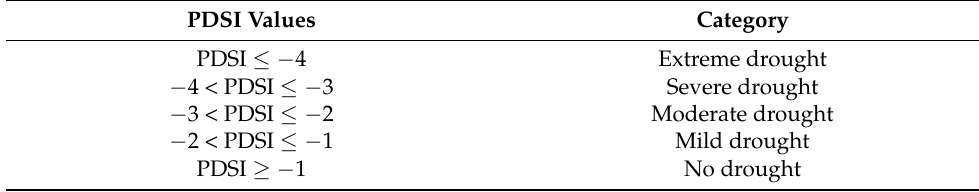
Table 4. Classification of drought based on PDSI [58].